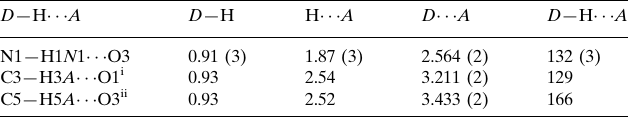
Hydrogen-bond geometry (A˚ , (cid:2)